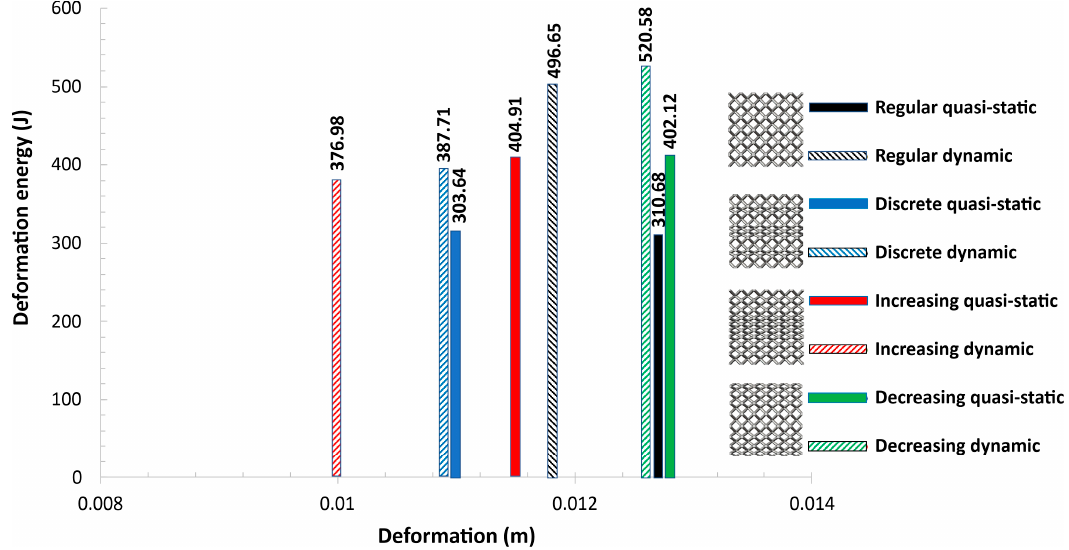
Figure 21. Comparison of the deformation energy values obtained in quasi-static and impact compression tests.